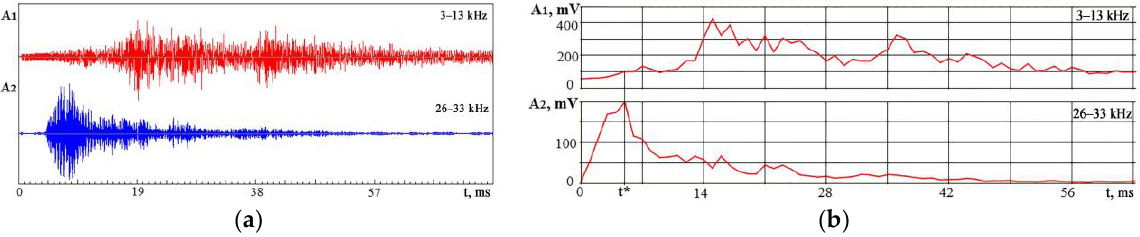
Figure 9. VA signal amplitude changes in time in two frequency ranges during electron beam action on a steel plate with a layer of Nb70Hf22Ti8 film at a charging voltage of 22 kV: ( a ) time records of VA signal components; ( b ) RMS amplitude changes in time for two frequency bands. t* – the moment, when the amplitude A 2 reached a maximum.